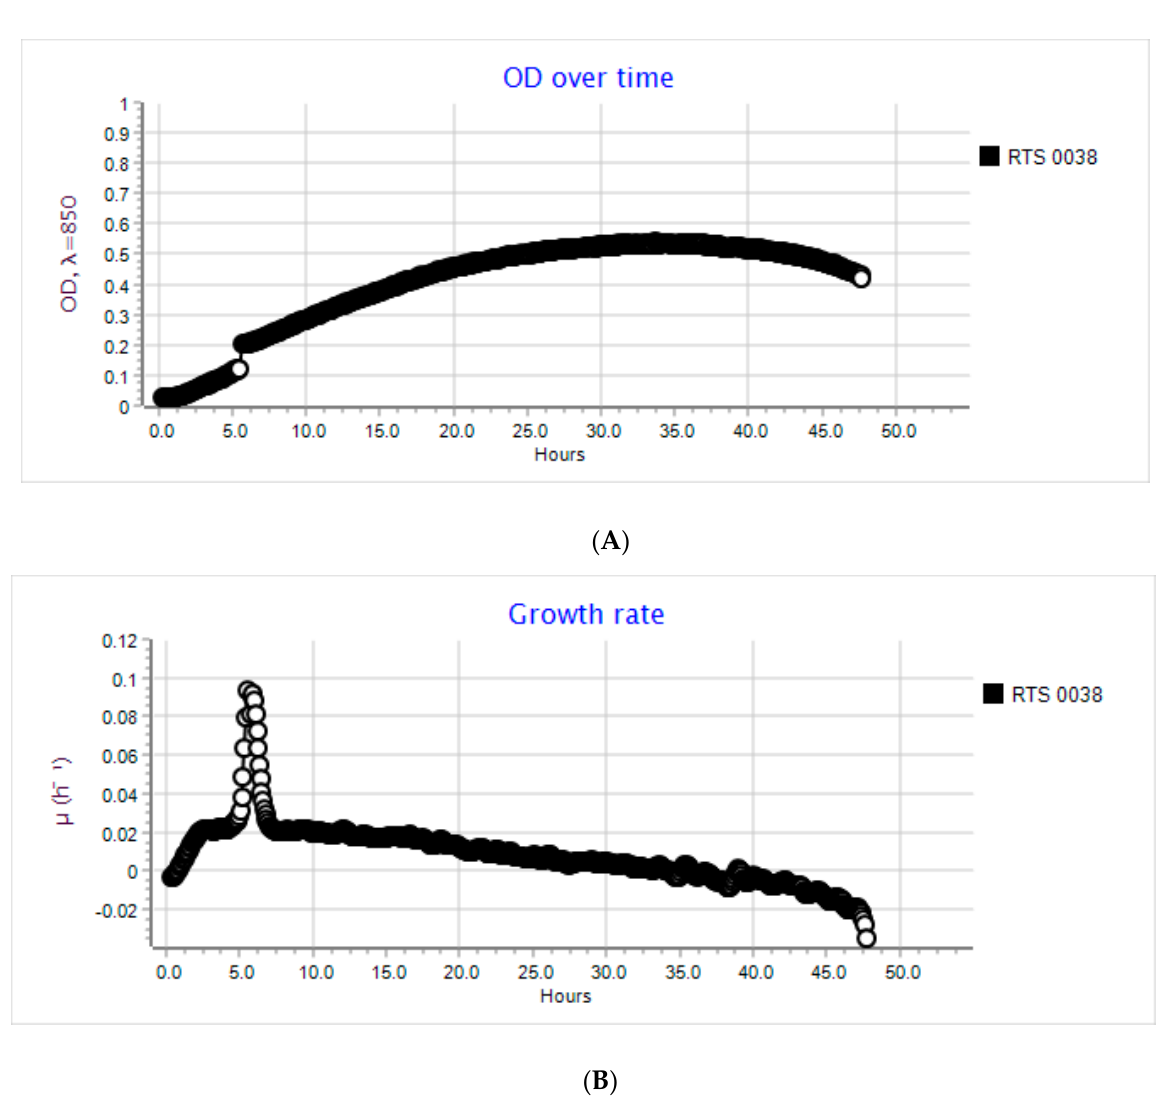
Figure 4. ( A ) OD over time for P. syringe after 48 h of incubation. Incubation devoid of phi 6 phages; OD—0.2. ( B ) The growth rate of P. syringe after 48 h of incubation. Incubation devoid of phi 6 phages; OD—0.2.